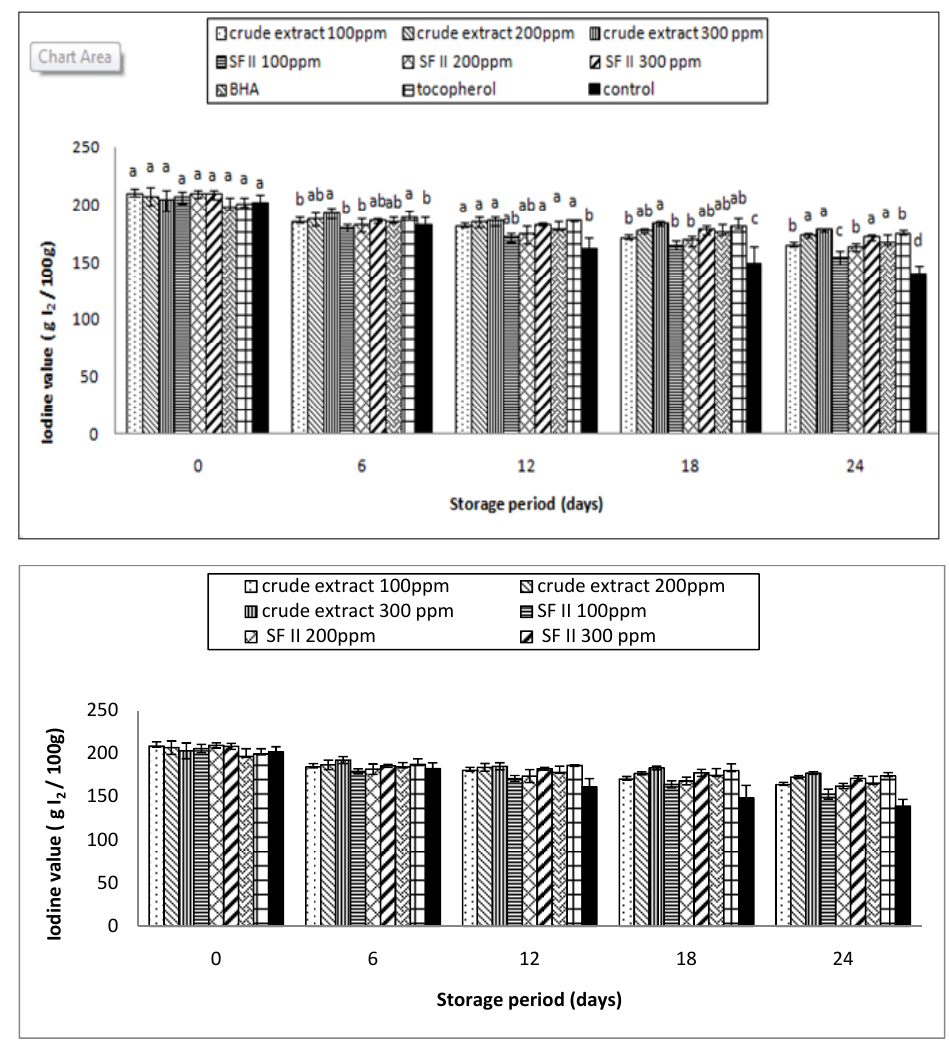
Figure 5. The Iodine value of the supplemented sunflower oil with rambutan extracts, BHA and tocopherol under accelerated storage at 65 °C for 24